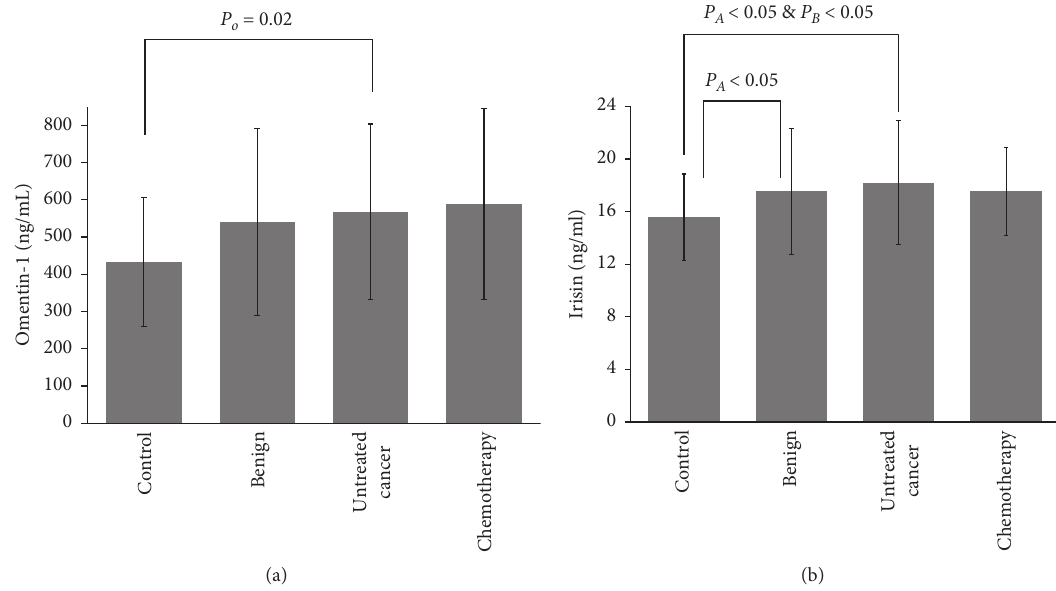
Figure 1: Omentin-1 (a) and irisin (b) serum levels across study groups. Post hoc unadjusted and adjusted comparisons were employed. Analysis of variance (ANOVA) or Kruskal-Wallis tests were used in unadjusted comparisons. Analysis of covariance (ANCOVA) was used in adjusted comparisons. Logarithmically transformed variables were used for both molecules. Adjusted models included: Model 1: adjusted for age. Model 2: adjusted for age and Ln-Body Mass Index (BMI). Model 3: adjusted for age, Ln-BMI and glucose levels. Model 4: adjusted for age, Ln-BMI, glucose levels, and total cholesterol levels. Model 5: adjusted for age, Ln-BMI, glucose levels, total cholesterol levels, and